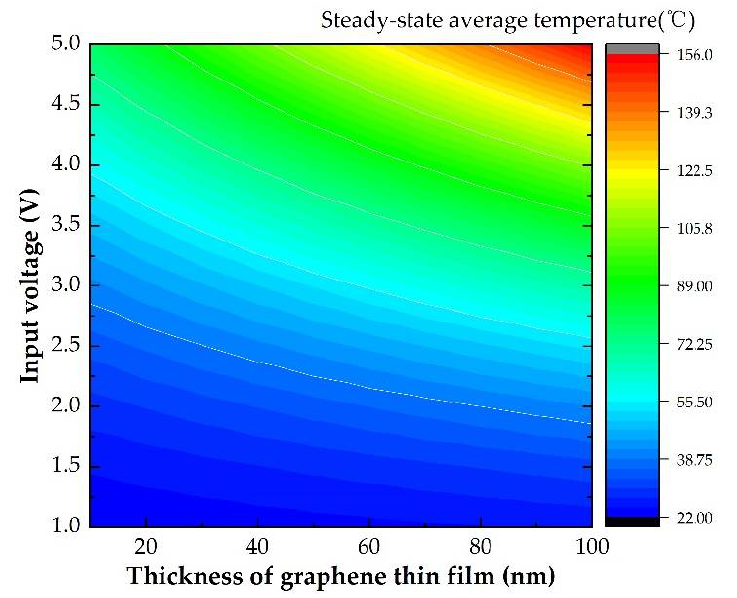
Figure 7. The average temperature of microheater with different input voltage for different thick- nesses of graphene thin film.